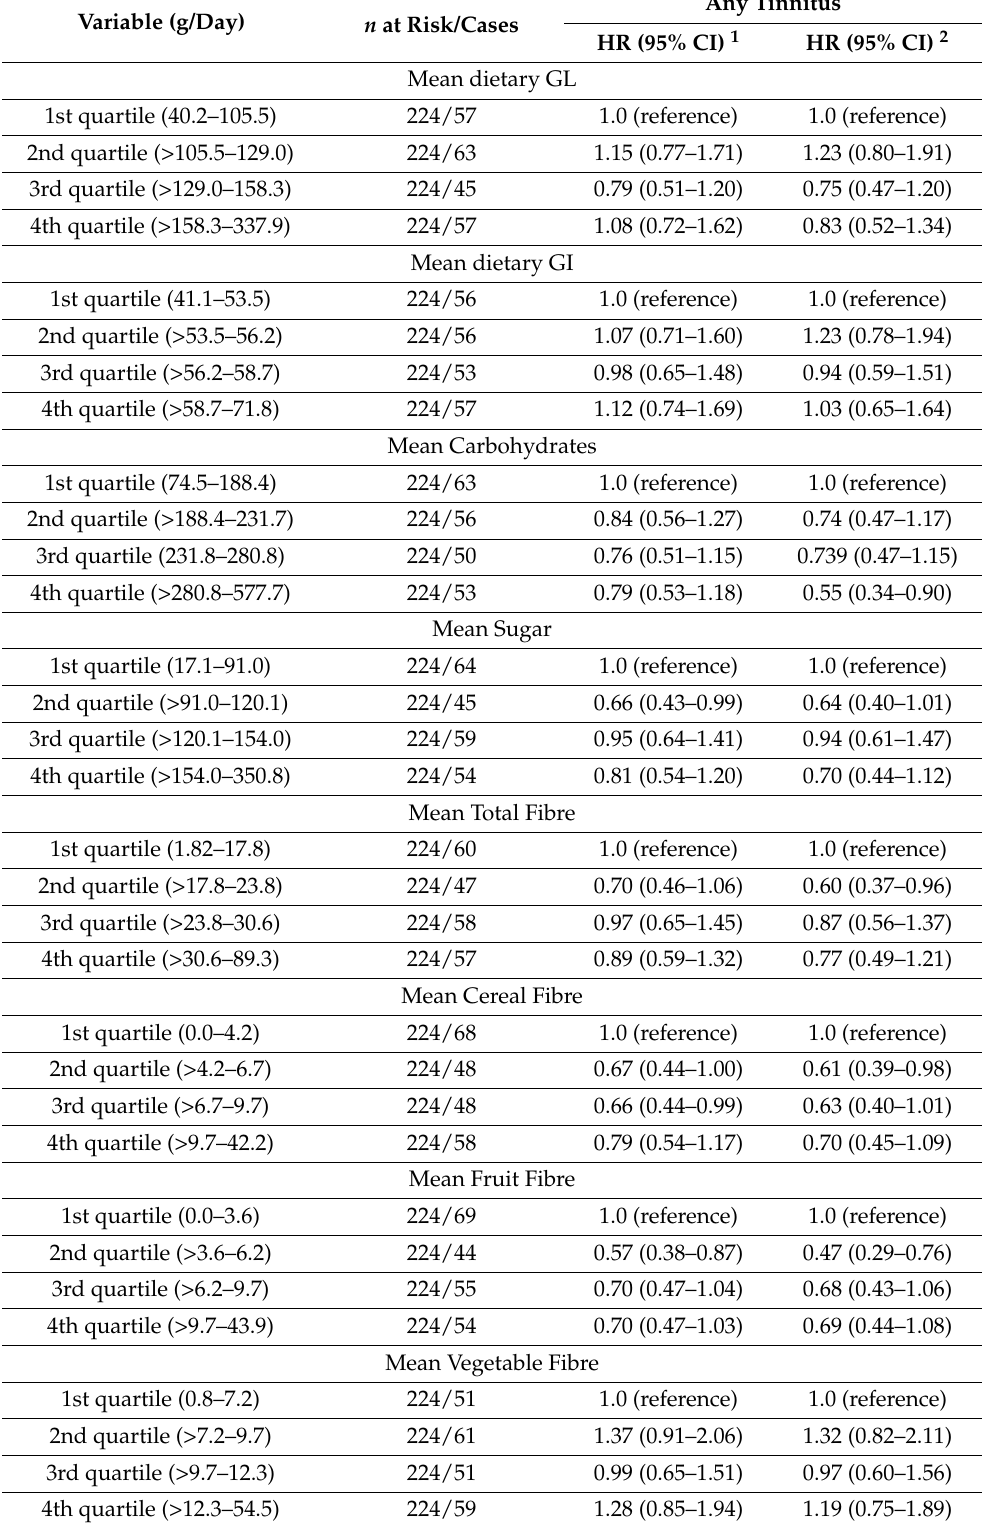
Table 2. Associations between mean dietary GI, dietary GL, carbohydrate, sugar, fibre (expressed in quartiles), and the 10-year incidence of